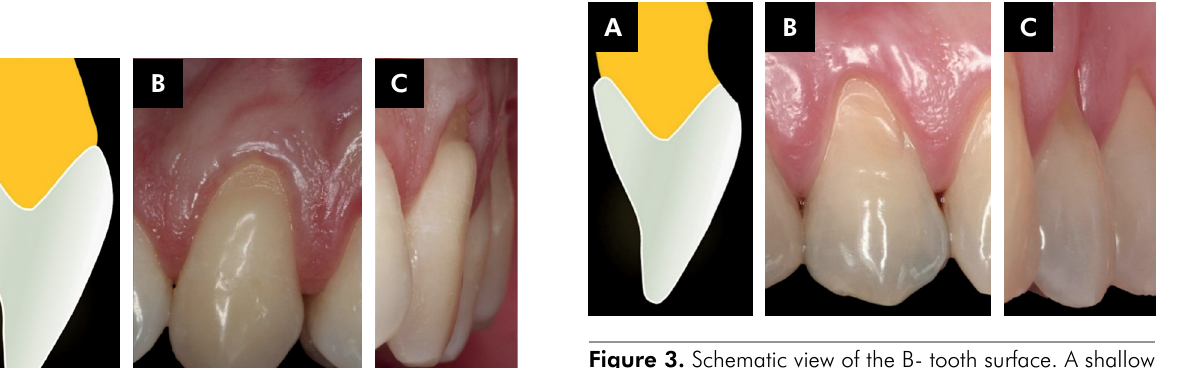
Figure 3. Schematic view of the B- tooth surface. A shallow non-carious cervical lesion (NCCL) is associated with gingival recession (GR) affecting both crown and root surfaces; there is no step (a). Facial view of a combined defect (CD) with recession type 1 GR and B- NCCL (b). Lateral view of the same CD. Note that the cementoenamel junction was lost, without the presence of a step